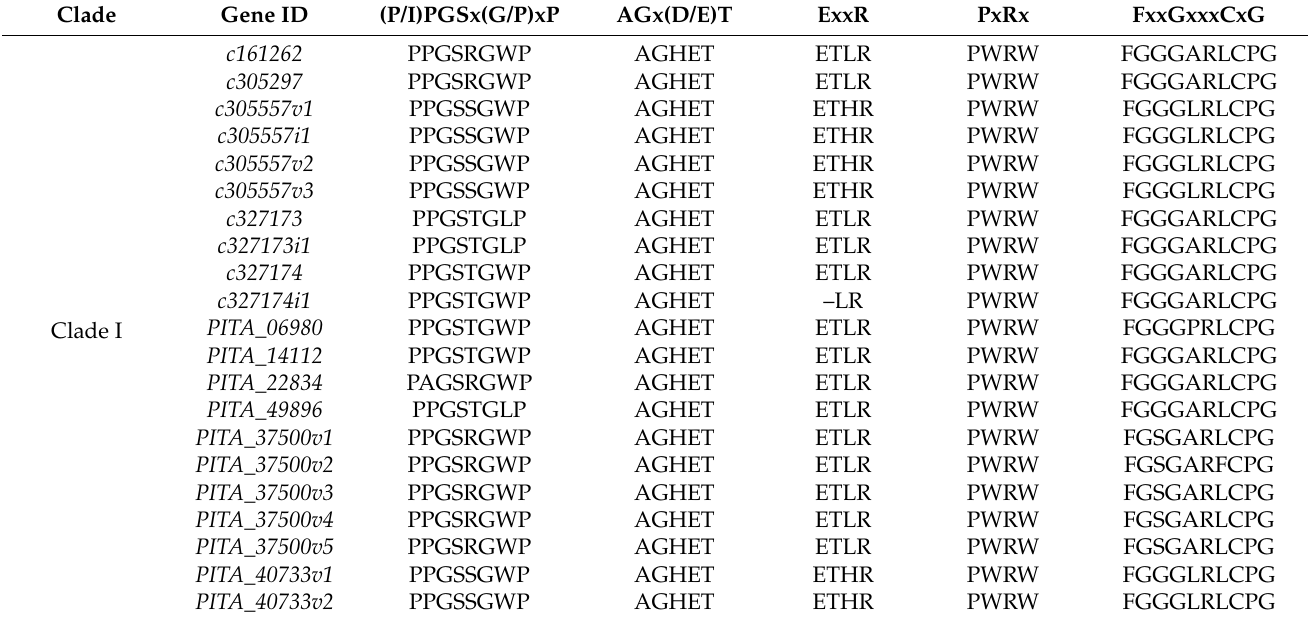
Table 2. The amino acid sequence of the conserved regions of